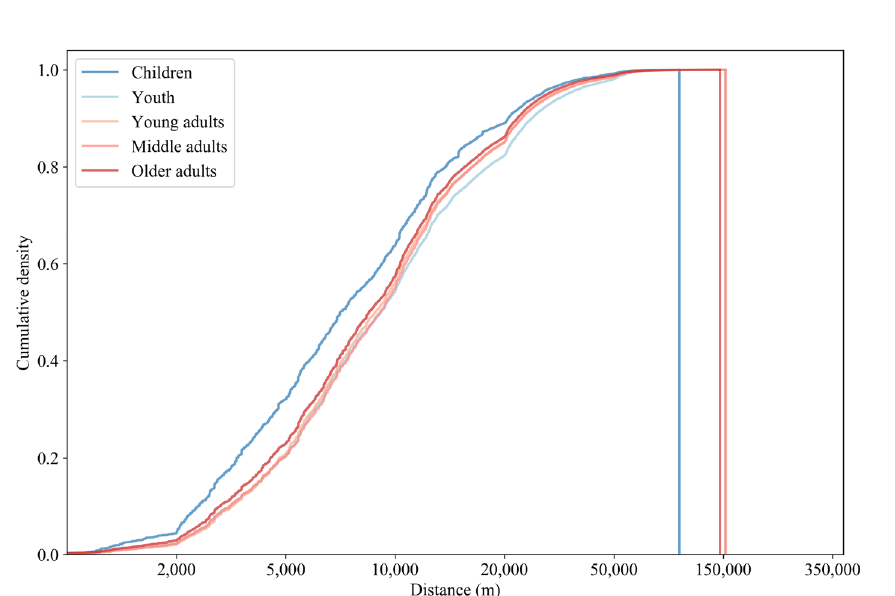
Figure 4. Distribution of trip distances across age